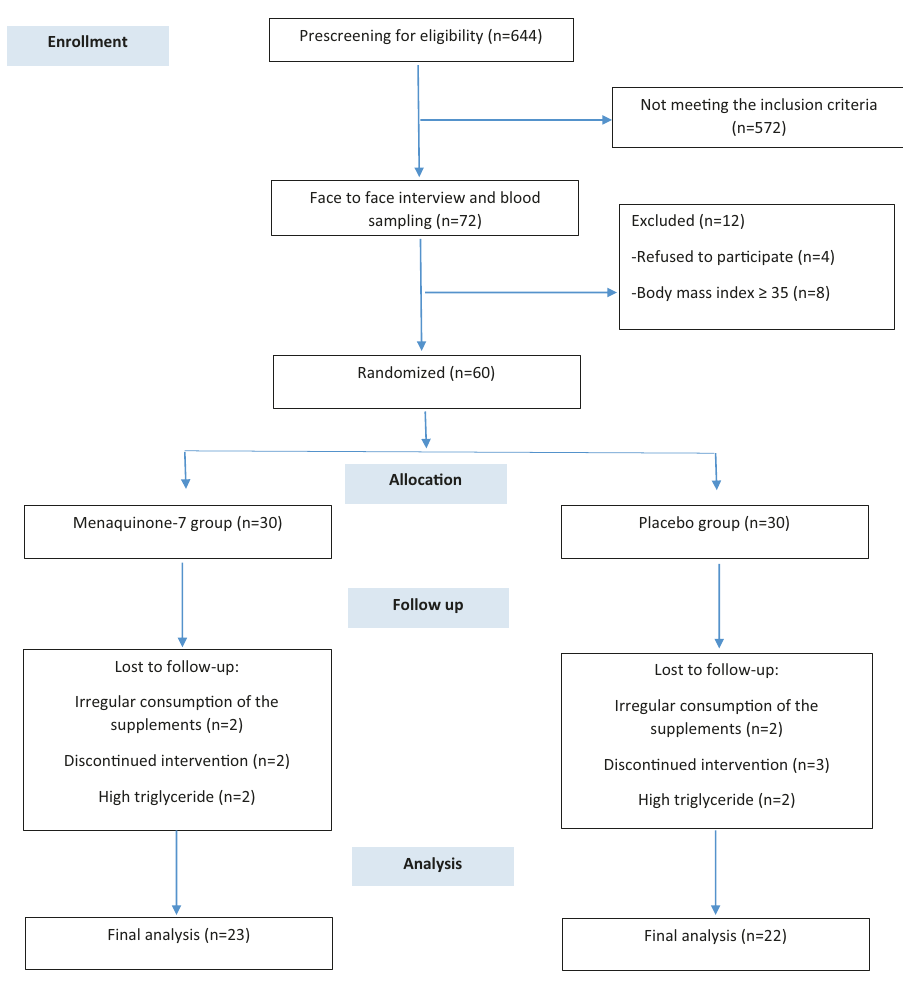
Fig. 1 Flow-diagram of the patient selection